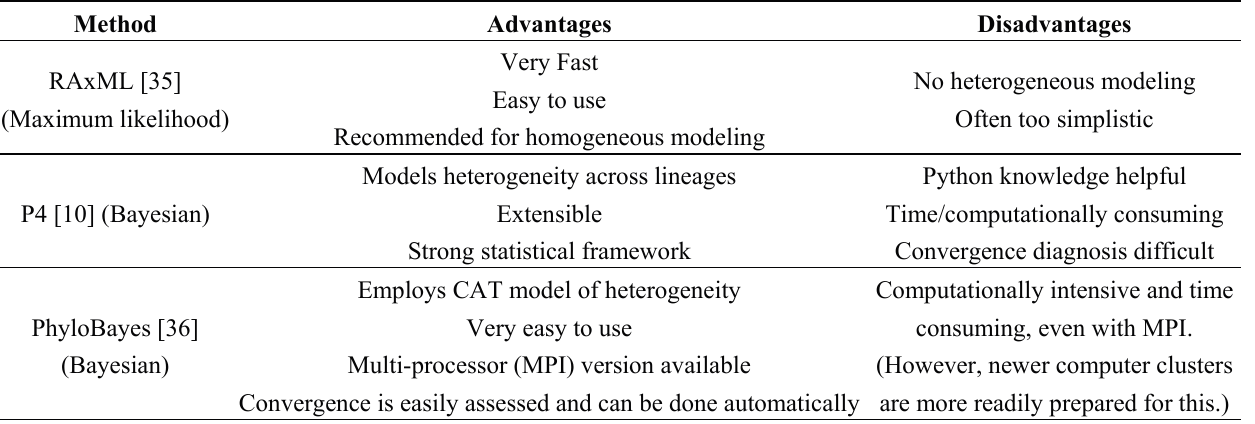
Table 1. A summary of some of the advantages and disadvantages of different approaches to phylogeny